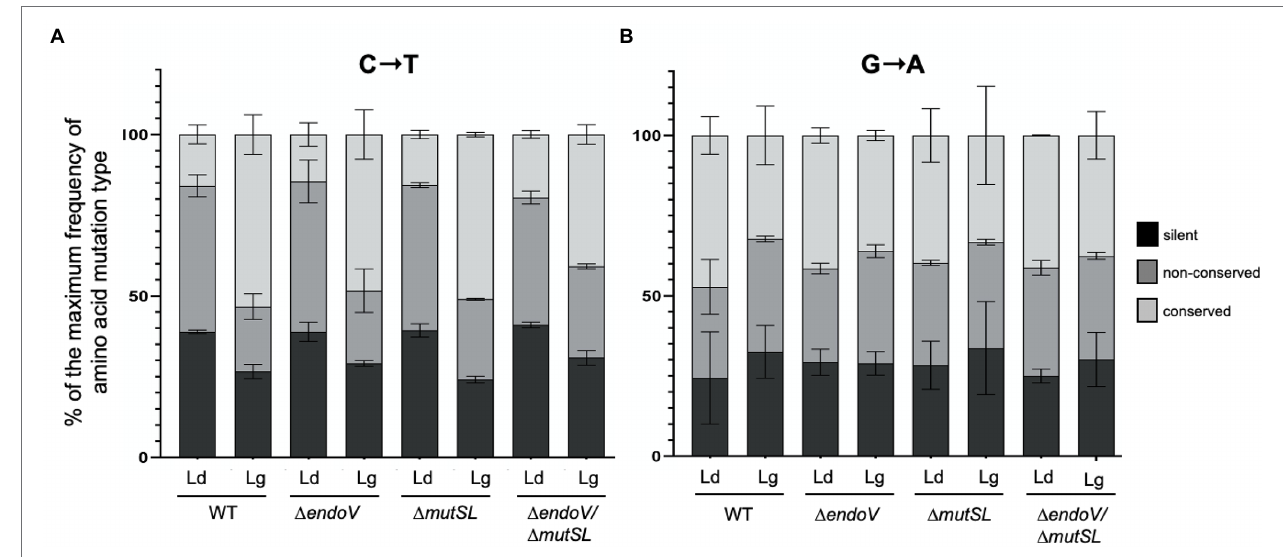
FIGURE 8 | Frequency of predicted silent (black bars), non-conserved (dark grey bars) and conserved (light grey bars) amino acid changes promoted by C → T (A) and A → G (B) transitions in the leading (Ld) and lagging (Lg) strands of the rpoB ROI analyzed. The bars represent the average frequency of each type of silent and amino acid mutations in the leading and lagging strands across the rpoB ROI considering the frequency of every C → T and A → G mutation. The frequency values, in the four strains, disregard the contribution of the hot spot 14 (H 482 ) in the rpoB ROI. Values represent the average frequency of two biological replicates. Error bars are